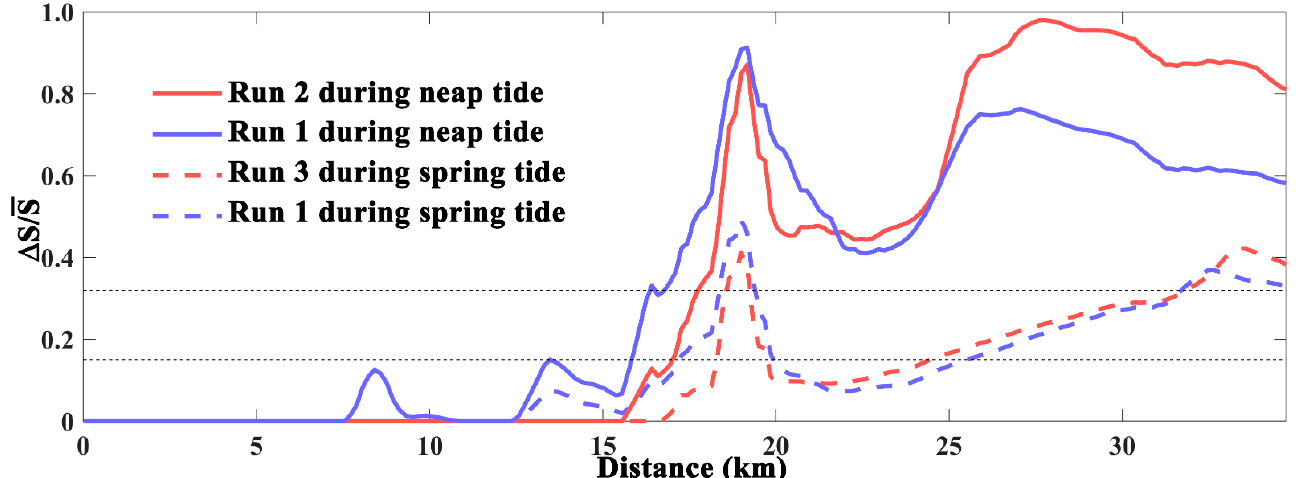
Figure 9. Stratification index on the along-channel section (the red line in Figure 1b with the red triangle indicating 0 km) during neap tide (colored solid lines) and spring tide (colored dashed lines). Black dashed lines indicate the thresholds of 0.15 and 0.32, respectively.